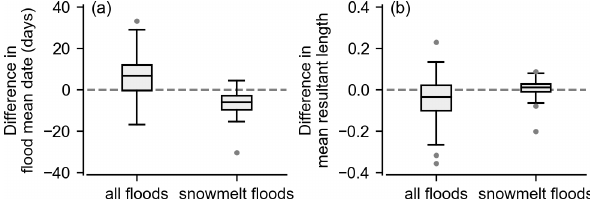
Figure B1. (a) Change in flooding mean dates (difference from 1985–2020 to 1950–1985) in 44 catchments, with a significant re- duction of snowmelt-driven floods in the Alps (region 1 in Fig. 7c), for snowmelt-driven floods and for all floods irrespective of their cause. For these catchments, the overall proportion of annual max- imum discharges caused by snowmelt has decreased from 49.0%